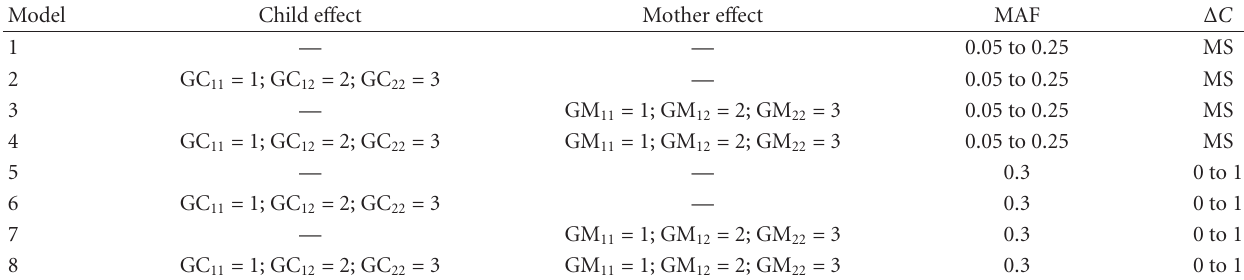
Table 2: The eight simulation models used for evaluation of the fetomaternal association